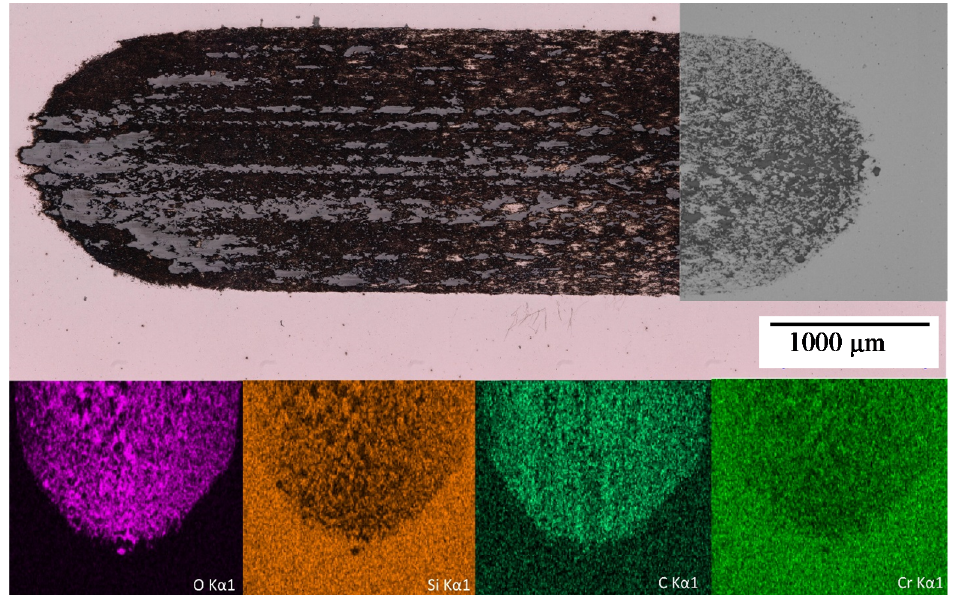
Figure 6. Adhesive wear test scar of SIHARD S250 steel when sliding against a hardened 100Cr6 bearing steel ball, with corresponding EDS mapping.